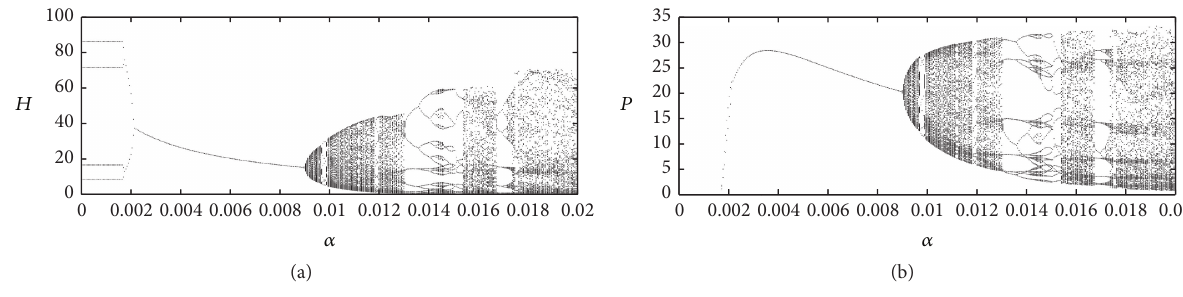
Figure 11: Bifurcation diagram with respect to parameter 𝛼 . The parameter values are as follows: 𝑇 = 10 , 𝑇 ℎ = 0.5 , 𝐾 = 50 , 𝛾 = 1 , 𝛿 = 0.5 , 𝜃 = 1 , 𝑞 = 0.2 , and 𝑟 = 2.8 .